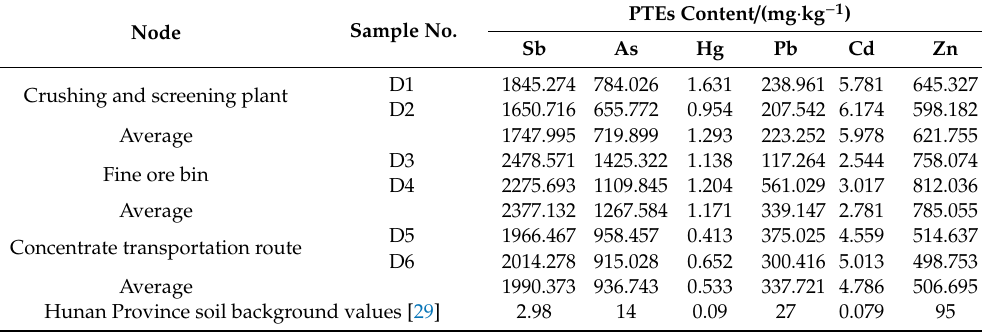
Table 2. PTEs contents in dust samples from nodes in antimony processing plant.